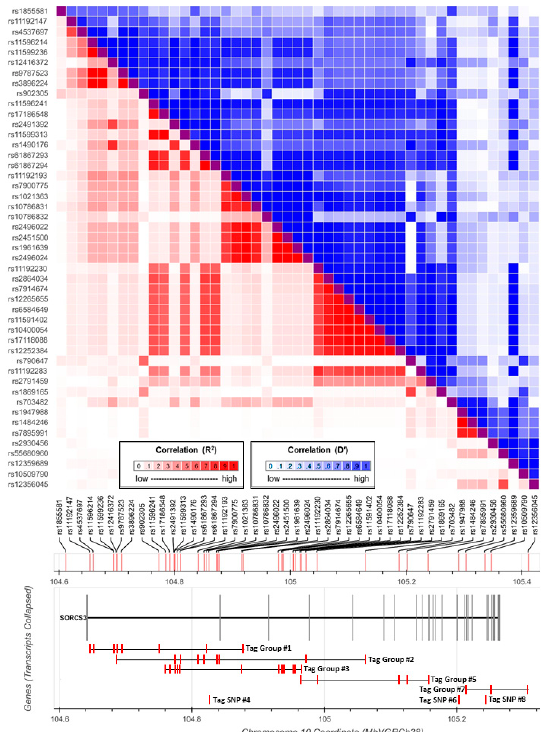
Figure 1. Workflow of the study design employed to ask multiple research questions related to SORCS3 ′ s association with brain-related disorders and traits.